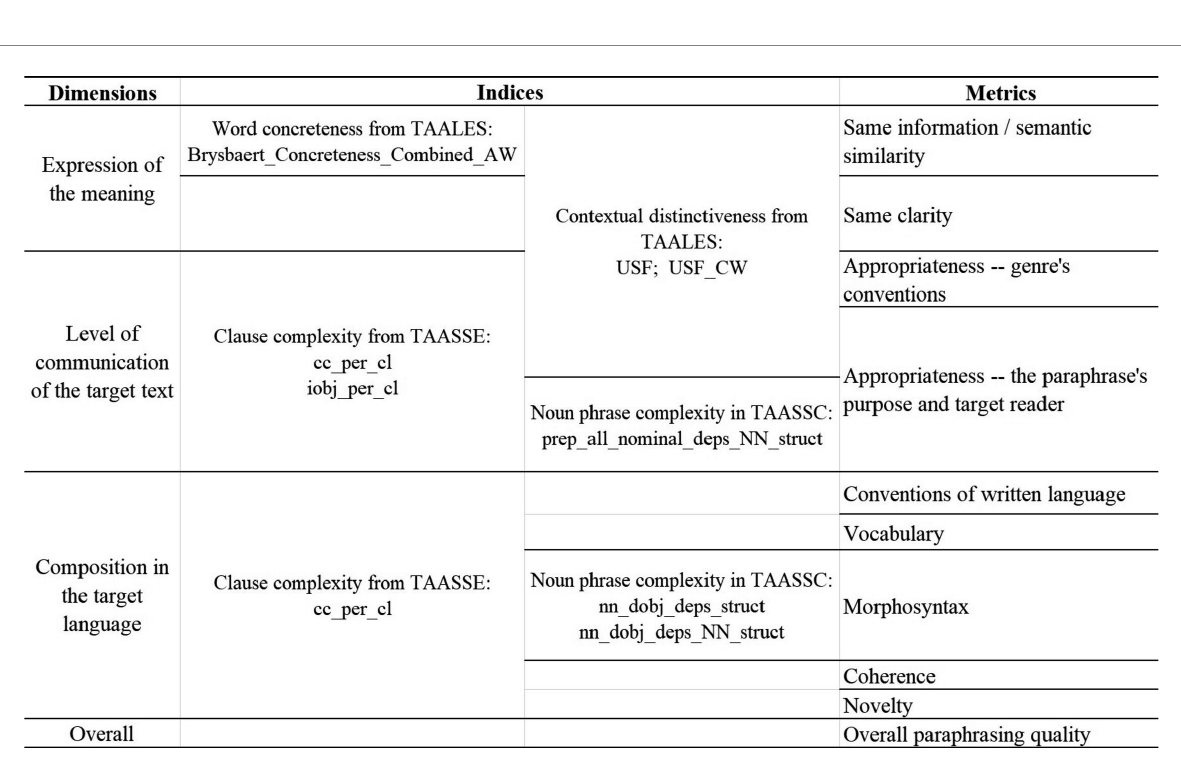
FIGURE 7 The NLP-assisted Evaluation Framework for